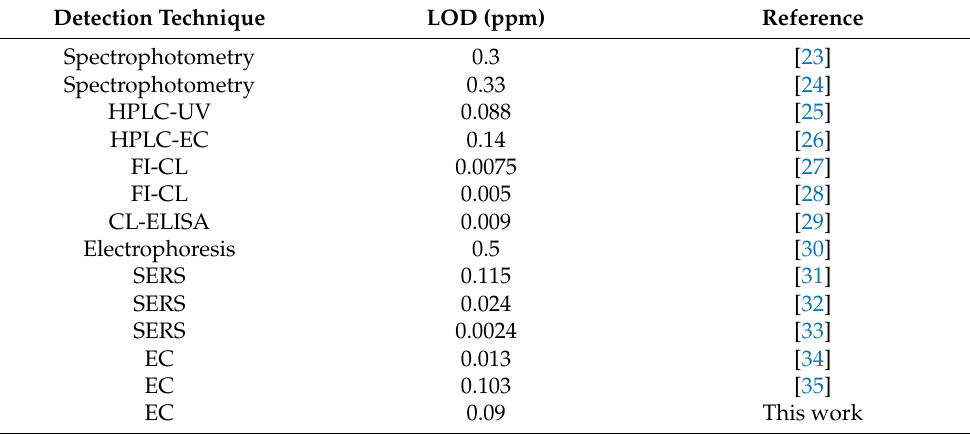
Table 1. Comparison among several methods for the determination of